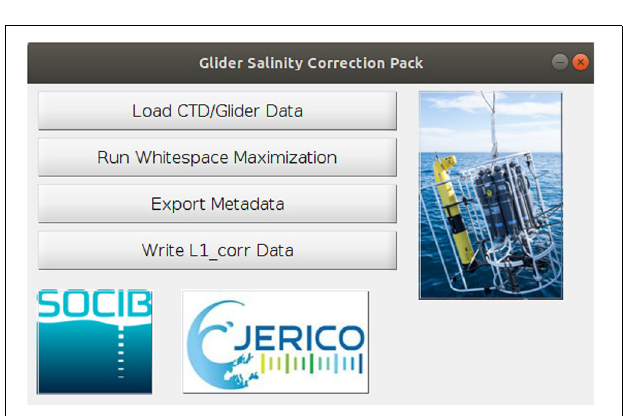
FIGURE 6 | The MATLAB GUI for the SOCIB Glider salinity correction